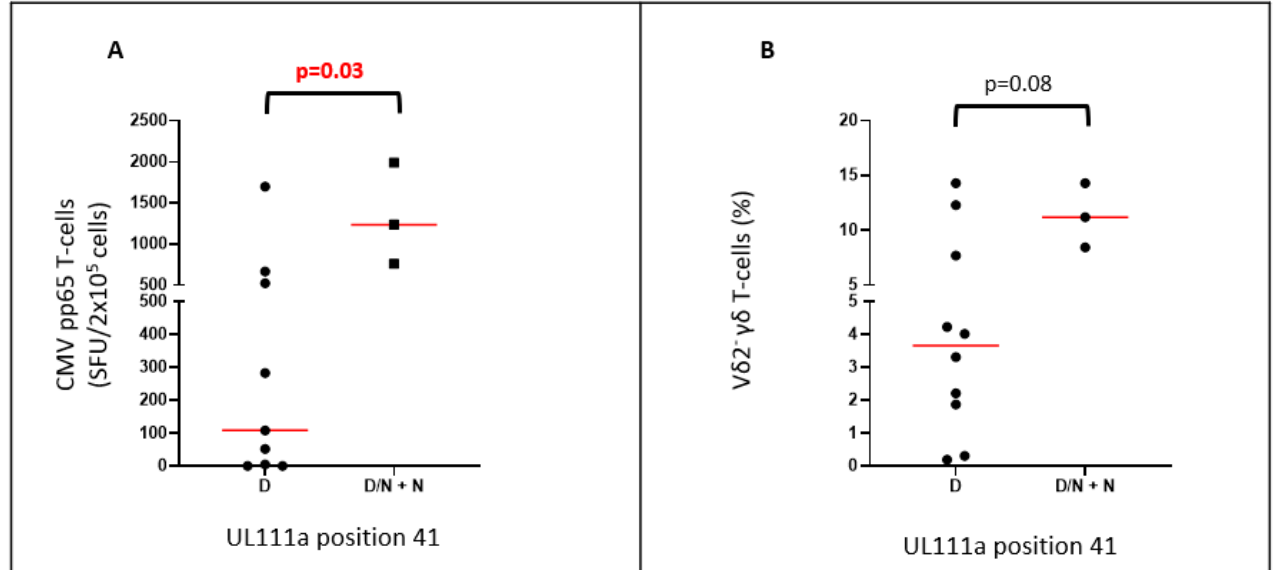
Figure 2. RTR carrying HCMV with the D41N variant have more HCMV-reactive T cells and higher proportions of V δ 2 − γδ T-cells: ( A ) comparison of HCMV pp65 specific T-cell responses in RTR carrying HCMV with D at position 41 and those with either D/N or N; ( B ) comparison of proportions of V δ 2 − γδ T cells in RTR carrying HCMV with only D at position 41 and those carrying D/N and only N.